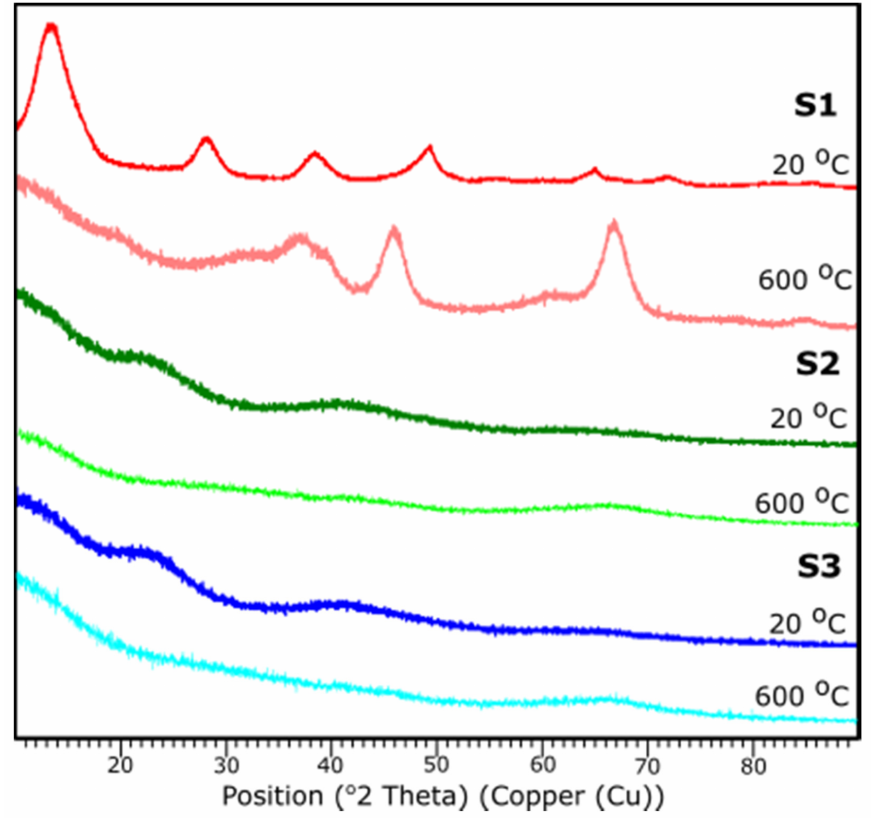
Figure 8. XRD diffraction patterns of the samples S1, S2, S3 at 25 and 600 ◦ C. Based on the XRD analysis, S1 indicates the crystalline structure of the material before and after thermal treatment. According to the card No. 21-1307 database [39], at 20 ◦ C the peaks stand for the pattern adequate to aluminum oxide hydroxide, AlO(OH). Reflections suit an orthorhombic crystal system with the space group: Cmc21. Peaks 14.48, 28.11, 38.25, 45.65, 48.81, 51.44, 55.09, 60.45, 63.88, 64.78, 67.53, 71.73, respectively, corresponds to h, k, l positions (020), (120), (031), (131), (051), (220), (151), (080), (231), (002), (171), (251). The sample S1 after the thermal treatment represents diffraction peaks characteristic to γ -Al 2 O 3 , according to JCPDS Card No. 29-0063 database. Indicated peak list 37.60, 39.49, 45.79, 60.89, 66.76 corresponds, respectively, to the (311), (222), (400), (511), (440). Identified peaks refer to the reflections of the cubic crystal system of γ -Al 2 O 3 with lattice constant of a = b = c = 0.790 nm, space group: